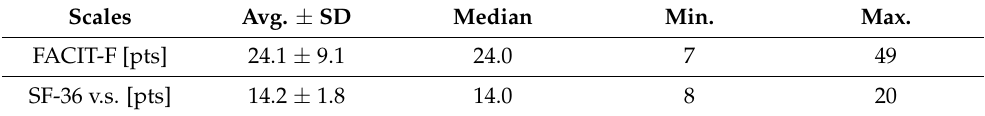
Table 3. Fatigue on the FACIT-F scale and vitality on the SF-36 scale vitality scores. Scales Avg. ±